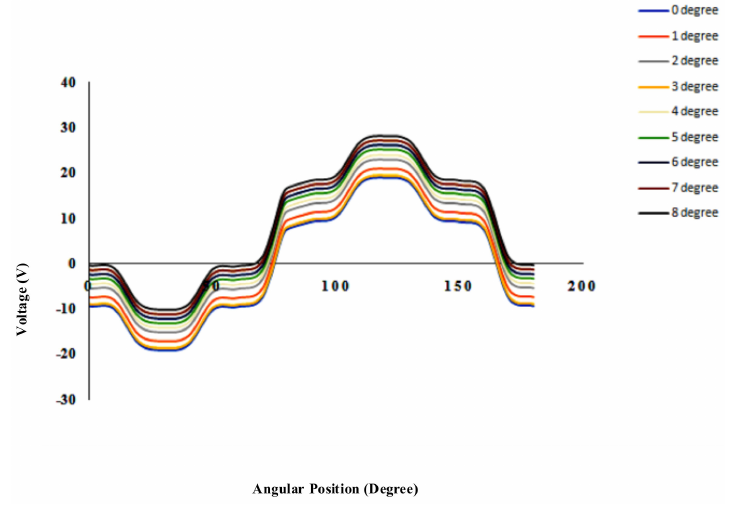
Figure 13. Comparison of